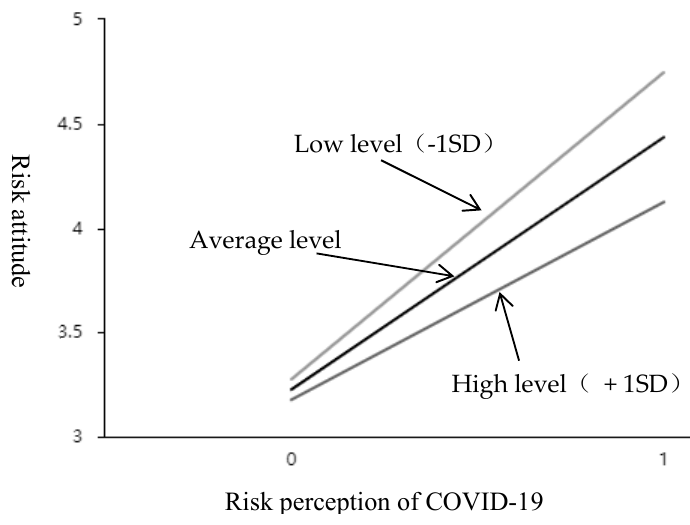
Figure 3. The effect of interaction between RP and LA on RA.